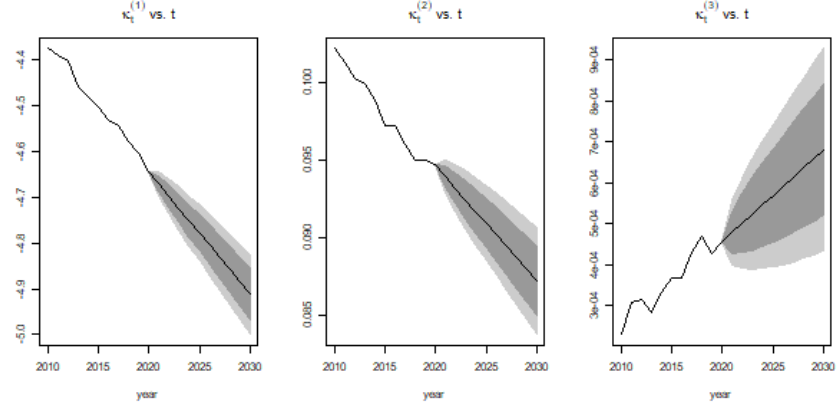
Figure 15. Parameter Forecast using the Quadratic Cairns–Blake–Dowd